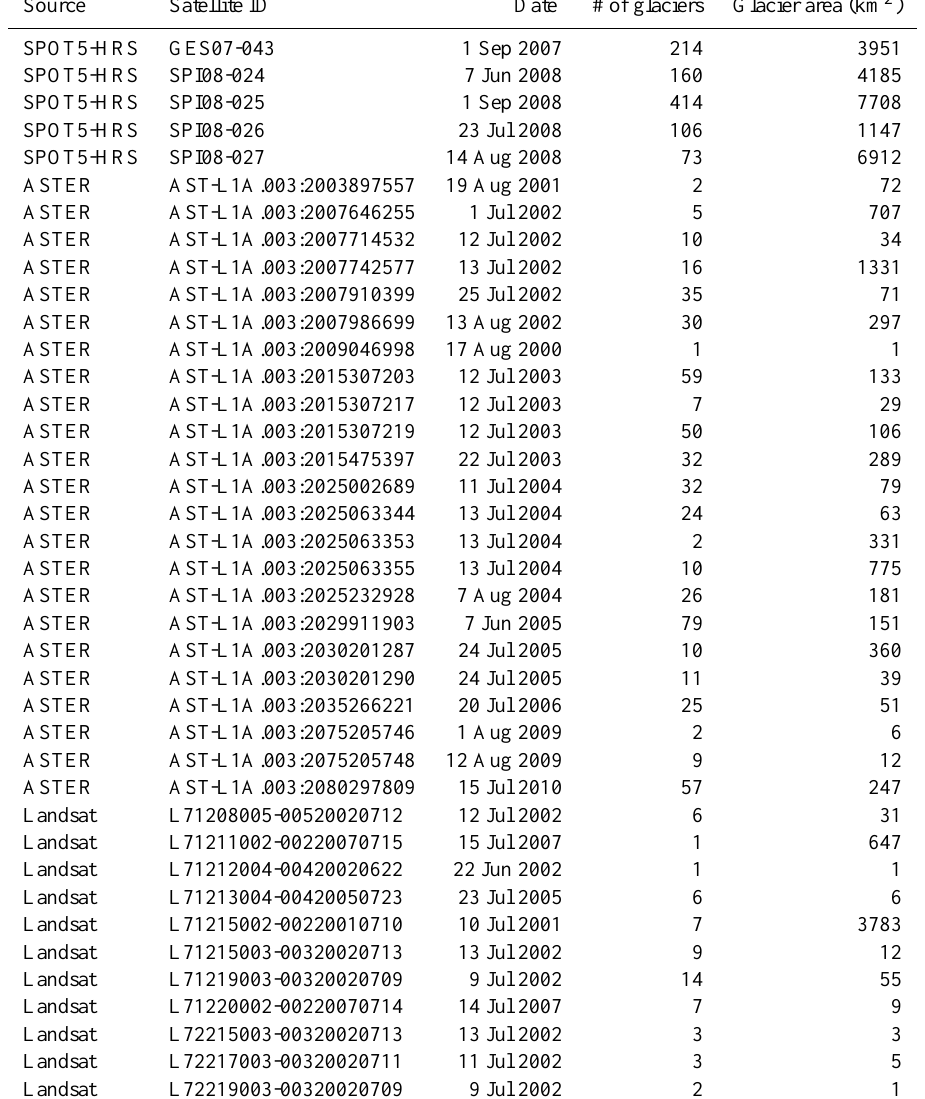
Table 1. Data sources used for the compilation of the most recent Svalbard glacier inventory, GI 00s .